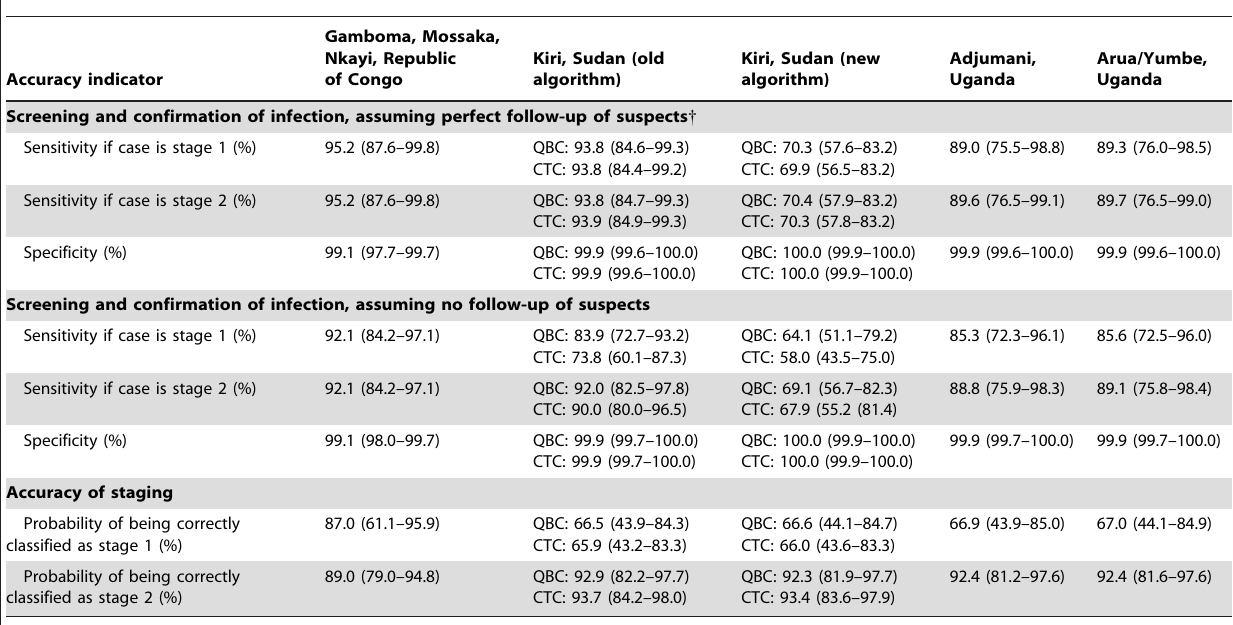
Table 4. Estimated sensitivity, specificity and accuracy of staging of HAT diagnostic algorithms (baseline scenario).